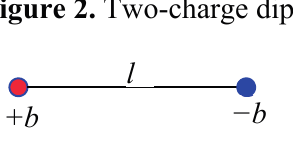
Figure 2. Two-charge dipole.